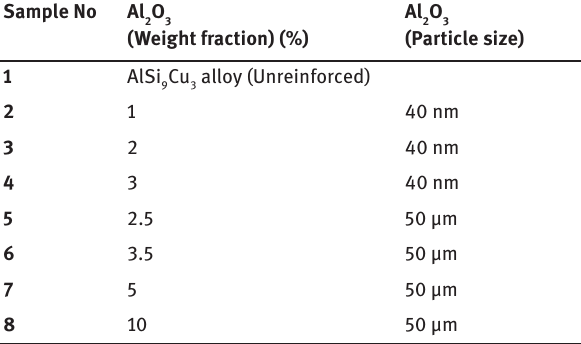
Figure 1: SEM image of nano-sized Al Table 1: Weight fractions and particle sizes of Al particles in AMMC and AMMNC